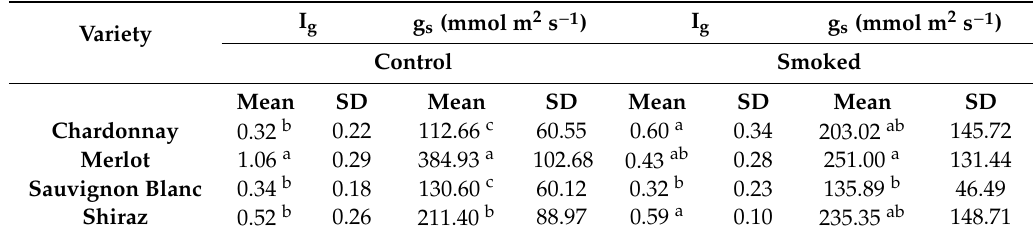
Table 1. Means and standard deviation (SD) per variety and treatment for the infrared index (Ig, unitless) and stomatal conductance (g s in mmol m 2 s − 1 ) calculated for all the images without sub-divisions.